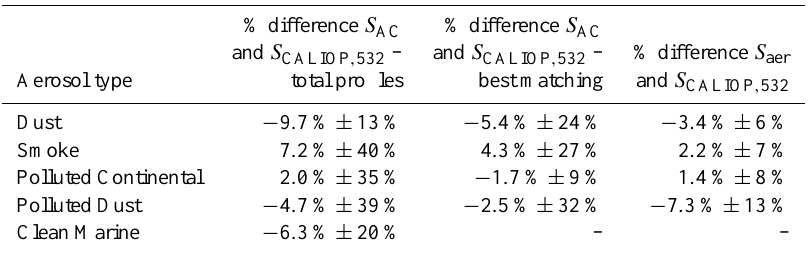
Table 8. Mean percentage lidar ratio difference between the lidar ratio calculation ( S AC and S aer ) and the CALIOP modeled value S CALIOP , 532 for all cases of aerosol